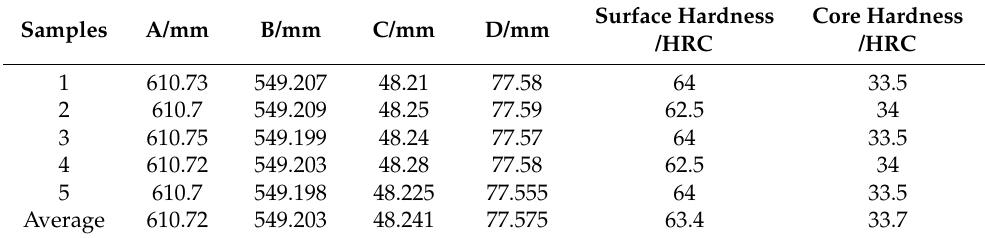
Figure 18. L65G high-precision gear, measuring center-measuring surface gear coordinates. Table 5. Deformation and hardness measurement results of face gear.